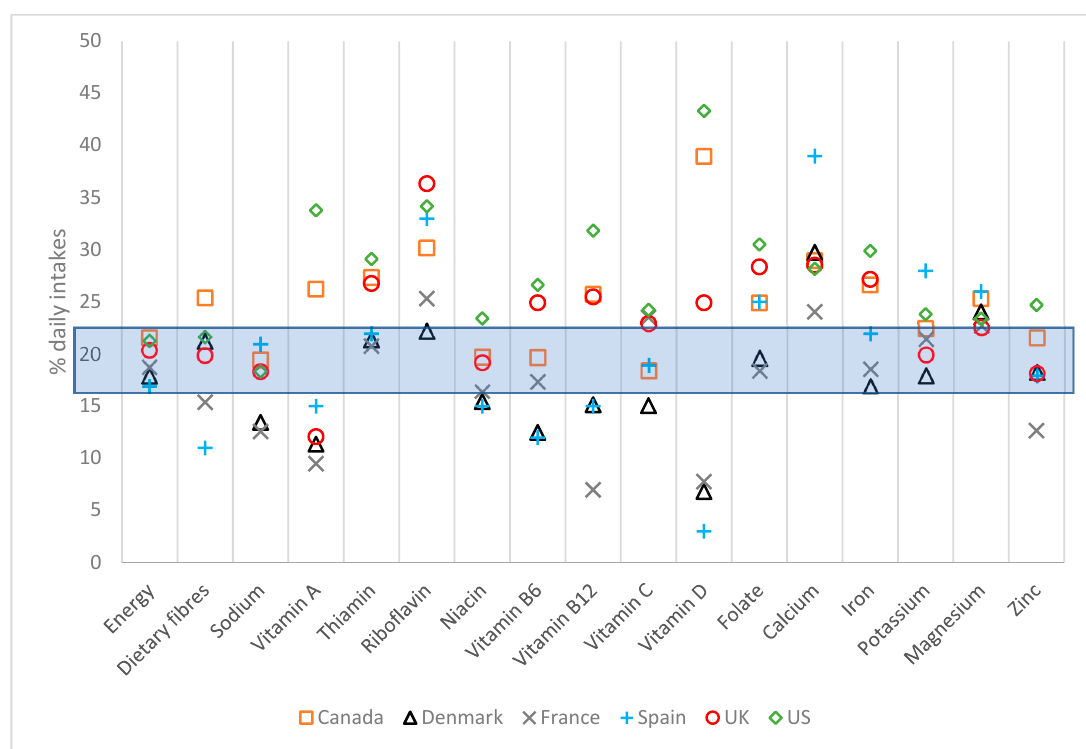
Figure 4. Contribution of breakfast to daily energy and nutrient intakes, total survey populations. The box represents observed contribution of breakfast to daily energy intakes.